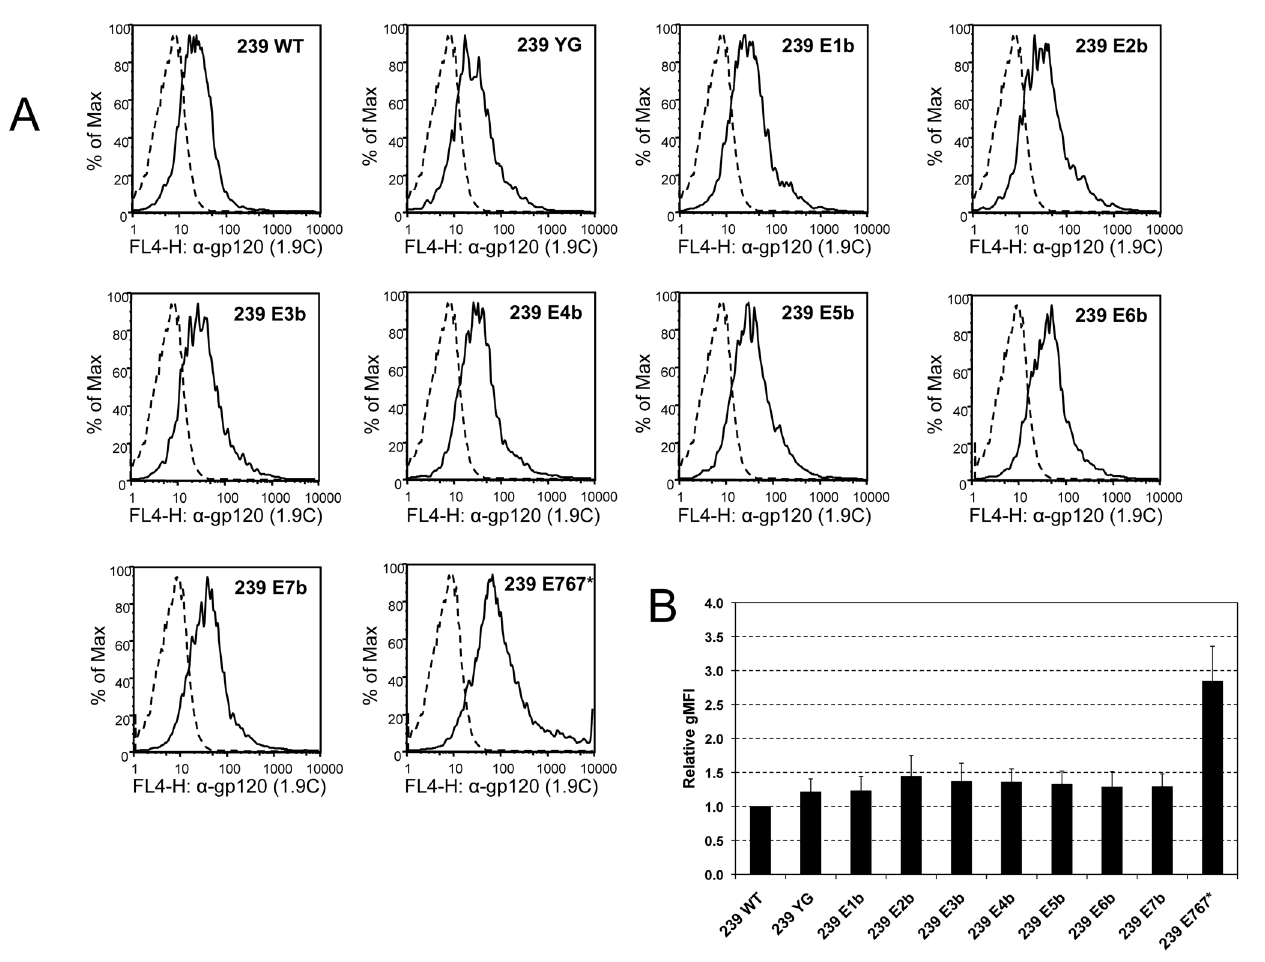
Figure 3. Cell-surface expression of SIVmac239 Env is not significantly altered by mutation of potential trafficking motifs. HEK293T cells were transiently co-transfected with SIVmac239 Env mutants and a GFP expression plasmid. On day 3 after transfection, cells were fixed and stained with anti- gp120 antibody 1.9C. Only the GFP-positive population was included in the analysis of Env expression. WT, wild-type; E767*, Env mutant with truncation at amino acid E767. ( A ) Histograms from a representative experiment. Solid line represents cells co-transfected with Env and GFP, dashed line shows negative controls (transfected with GFP only). ( B ) Relative geometric mean fluorescence intensity (gMFI), normalized for wild-type Env (239 WT). Error bars indicate standard deviation of four independent experiments.